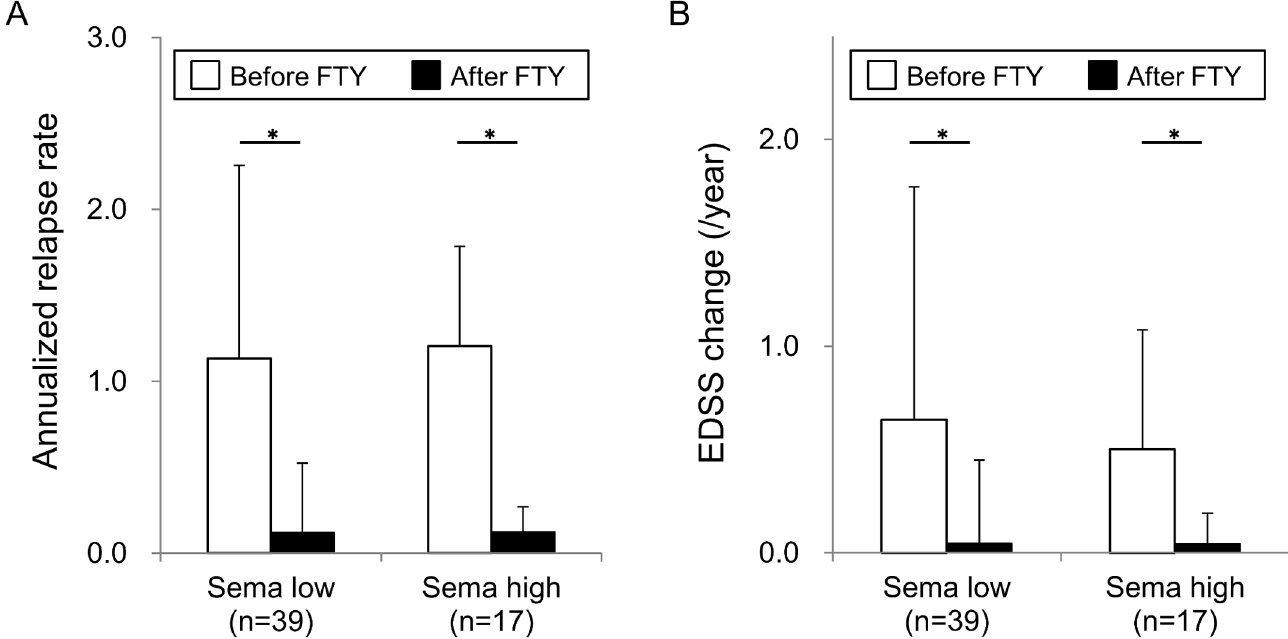
Fig 2. Fingolimod is effective for patients with high Sema4A. (A) Annualized relapse rate (ARR) before and after fingolimod treatment is shown. Fingolimod reduced ARR both for patients with low Sema4A levels and for those with high Sema4A levels. Data represent the mean ± SD. (cid:3) p (cid:20) 0.05. (B) EDSS progression (EDSS annual change) after fingolimod treatment is shown. There was no difference between patients with low Sema4A levels and those with high Sema4A levels.